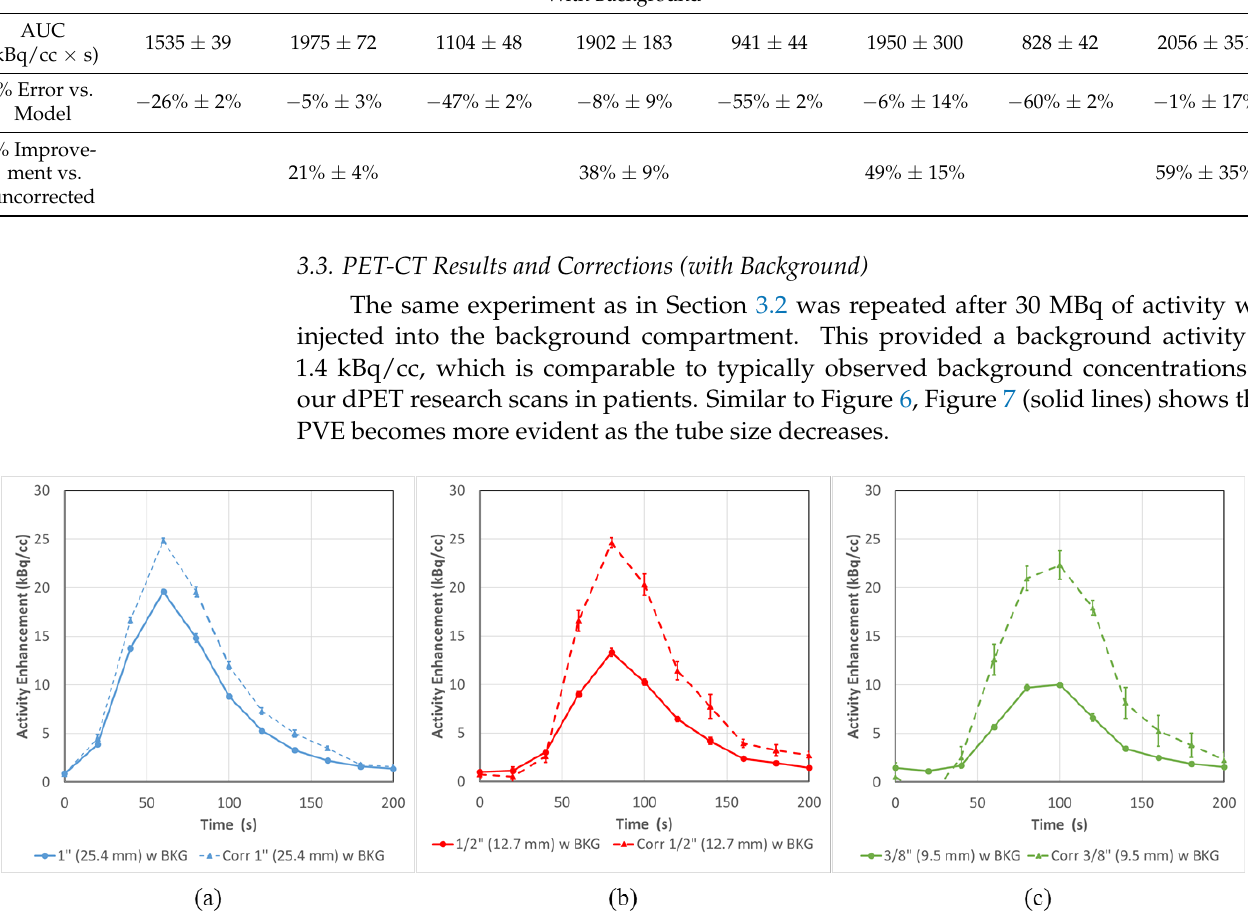
Figure 7. PVE in dPET Input functions at all tube sizes ( a ) 1” (25.4 mm), ( b ) 1 / 2 ” (12.7 mm) and ( c ) 3/8” (9.5 mm) can be substantially corrected even in conditions of background activity. The substantial PVE observed in the uncorrected (solid lines) input function can be corrected (dashed lines) by as much as 49 ± 15% for the 3/8” tube based on AUC. Error bars represent the standard error from multiple ROI regions (n = 5).